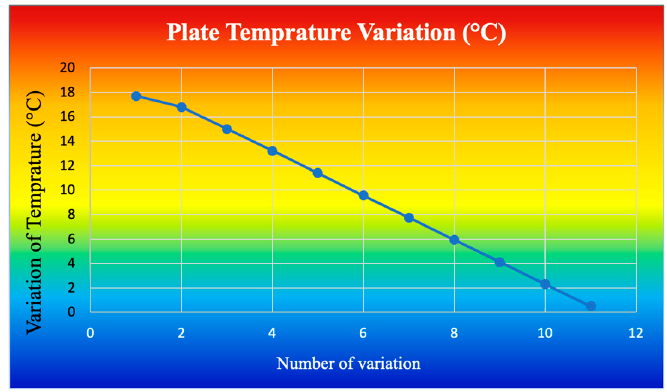
Figure 21. Temperature variation of the structure.